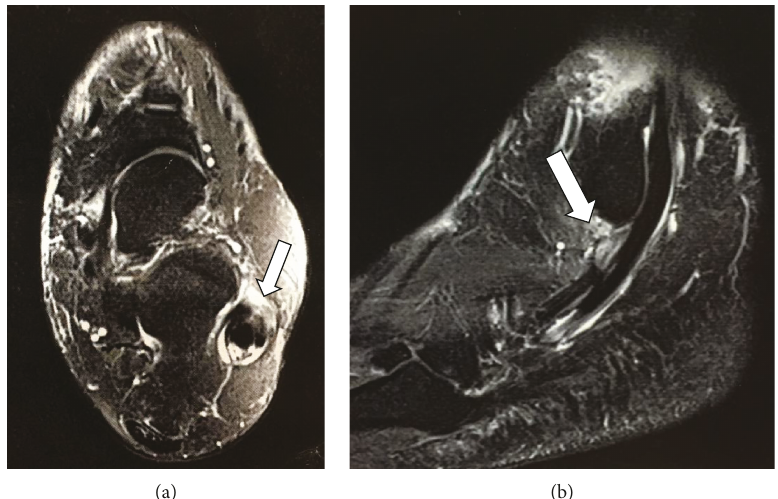
Figure 1: MRI showing PB tendon tears greater than 50% in the (a) axial and (b) sagittal views (white arrows).